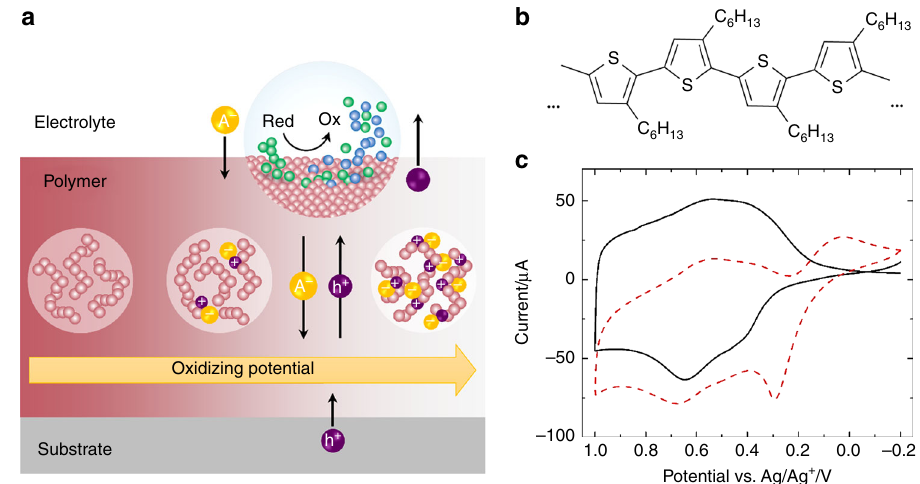
Fig. 1 Redox reaction coupled with hybrid electronic – ionic transport at a polymer electrode. a Oxidation of the redox species at the polymer/electrolyte interface is enabled by potential-dependent oxidation of the polymer fi lm coupled with intercalation of counter ions (A − ) from the electrolyte and changes in polymer morphology (center circles). b Molecular structure of P3HT. c Cyclic voltammograms (scan rate of 50 mV s -1 ) of an e-P3HT fi lm in the deposition bath (solid black line) and in a solution of 1 mM FcDM and 0.1 M TBAHFP in acetonitrile (dashed red